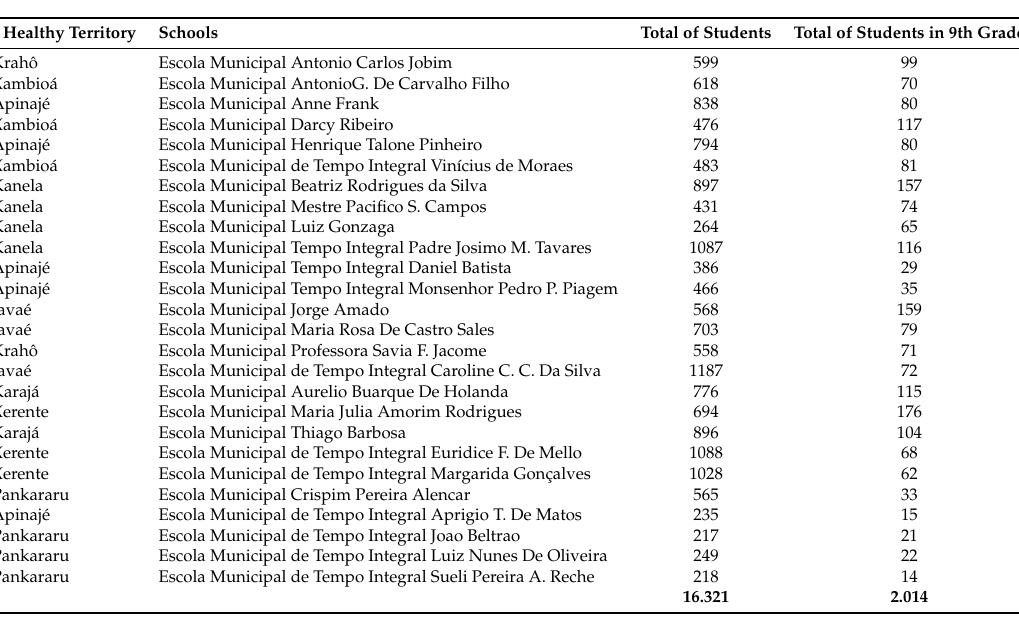
Figure 6. Map with the location of Palmas/TO. Source: Professor João Aparecido Bazolli [21]. Table 3. Palmas-TO Municipal Schools that have the 9th grade of Elementary School. Total number of students enrolled, number of students enrolled in 9th grade of Elementary School (Traditional) in 2017. Source: Table created by the author himself from data obtained from the Municipal Secretary of Education of Palmas/TO